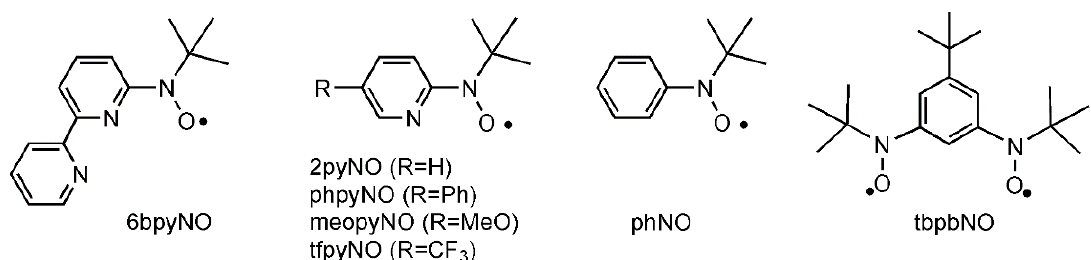
Figure 5. Structural formulas of 2pyNO derivatives and related compounds.